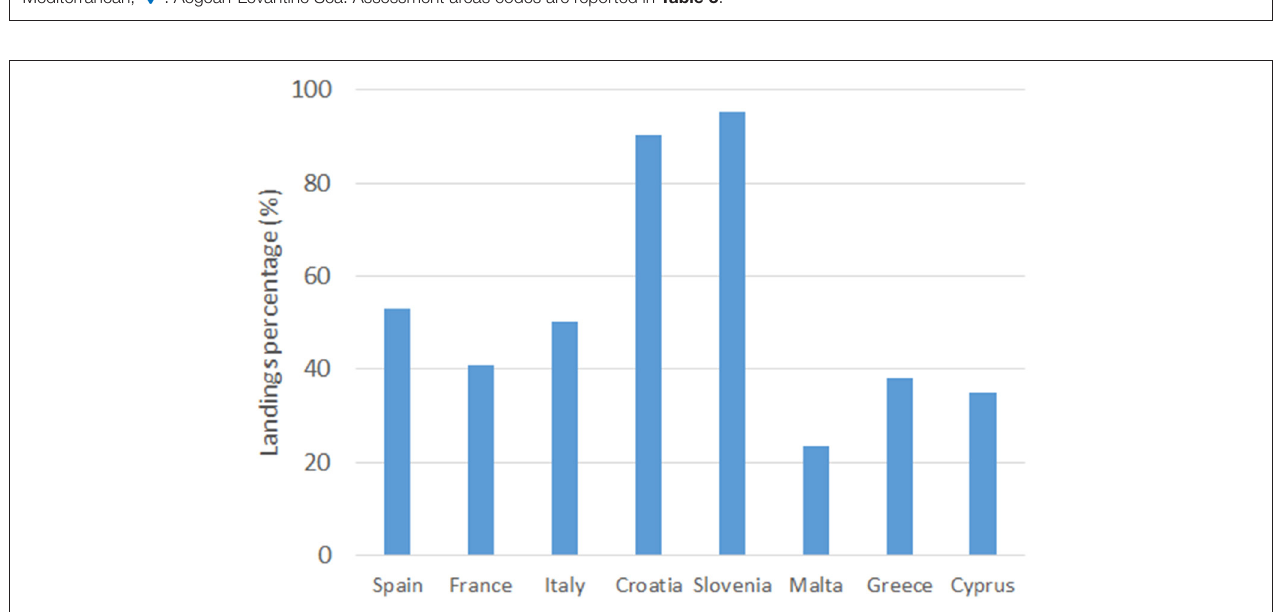
FIGURE 4 | Percentage of landings corresponding to the stocks selected by the EU member states within their Initial Assessment.